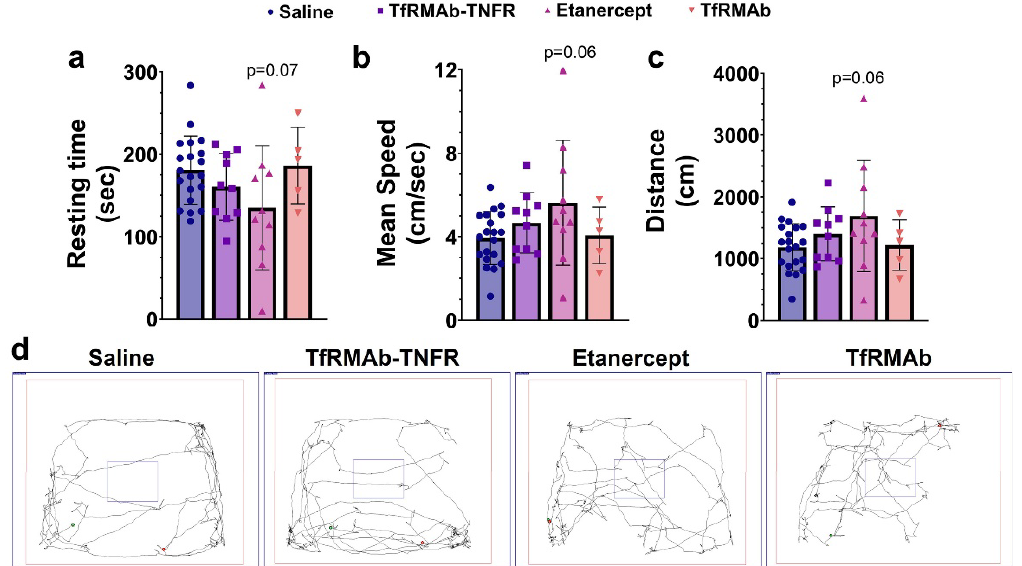
Figure 4. Effect of chronic TfRMAb-TNFR dosing on locomotion and exploration. The resting time ( a ), mean speed ( b ), and distance traveled ( c ) did not differ between any experimental group. The representative trajectory maps show mouse movement in the different groups ( d ). Data are presented as mean ± SD of n = 5–20 per treatment group, and data were analyzed using the one-way ANOVA with the Holm Sidak’s post hoc test.